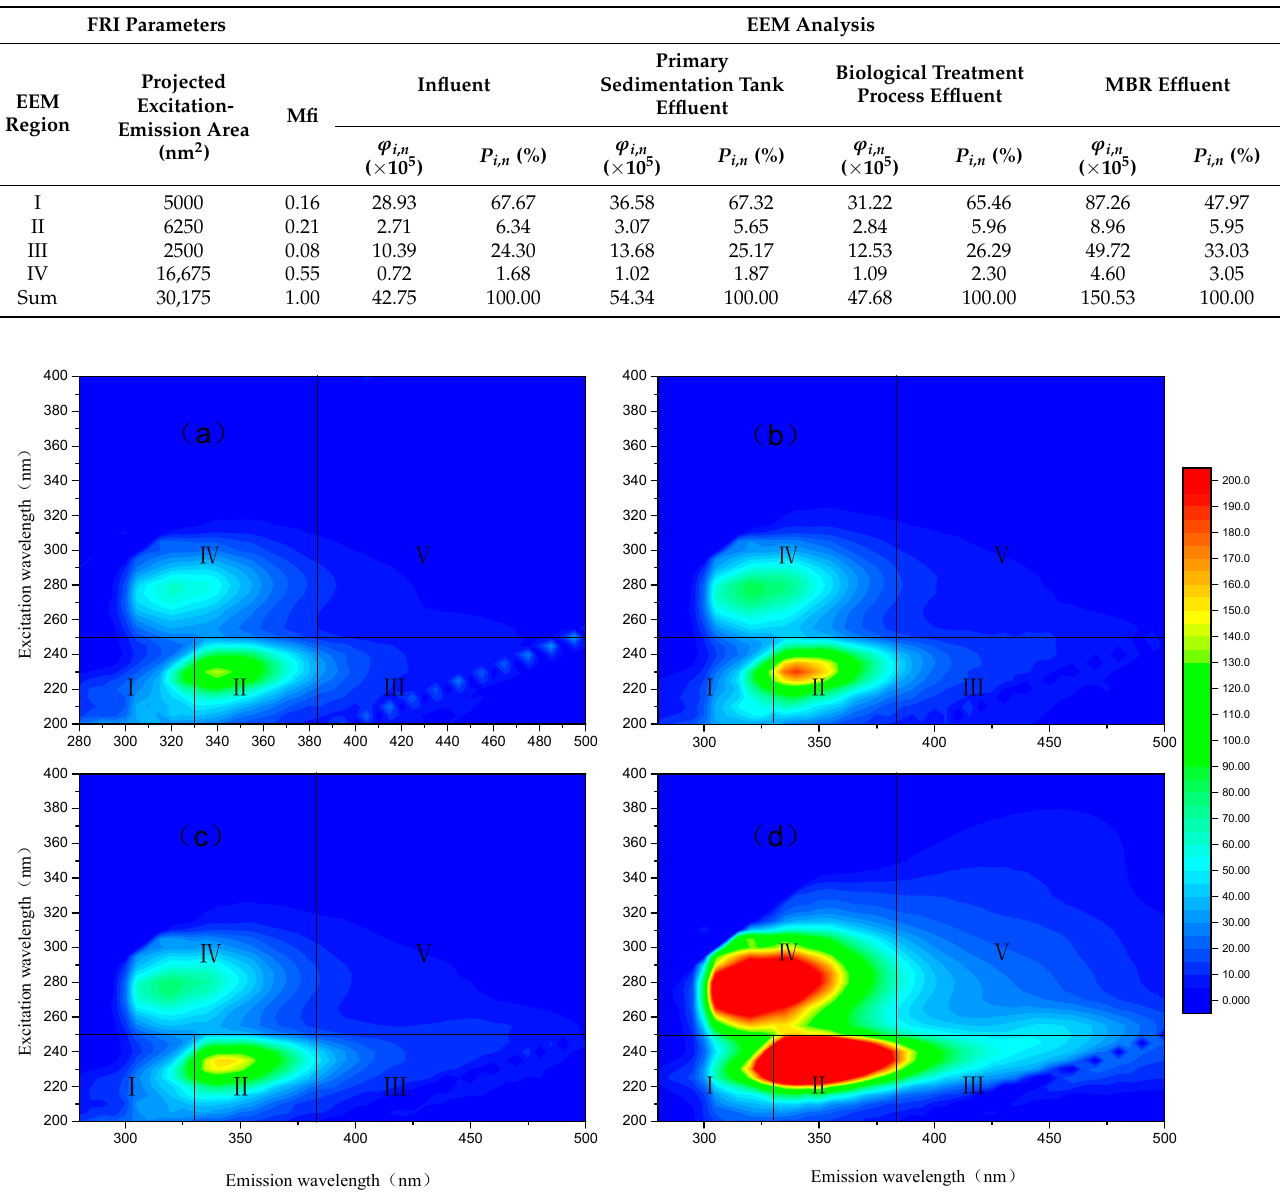
Table 2. FRI parameters for operationally defined 3D-EEM regions and volumetric ( ϕ ) and percentage ( p ) values for 3D-EEM analysis of the wastewater samples.